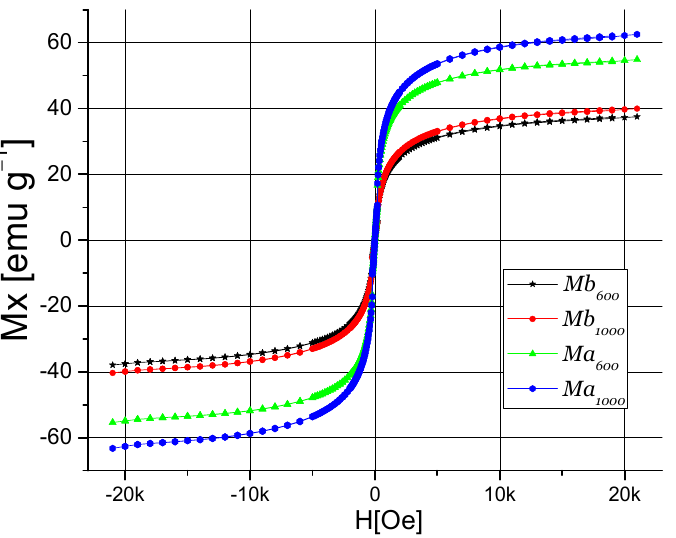
Figure 4. Cycles of Hysteresis magnetic curve of TrGO:Fe 3 O 4 powder: Mb 600 , Mb 1000 , Ma 600 , and Ma 1000.